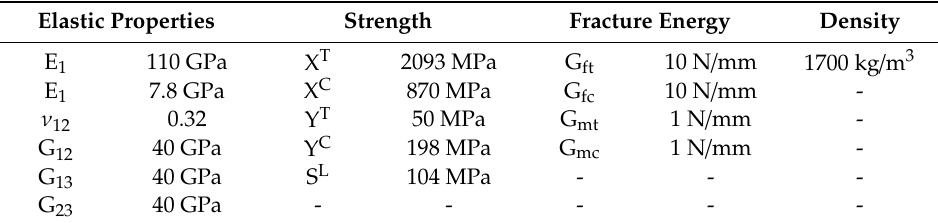
Table 1. Mechanical parameters of composite.